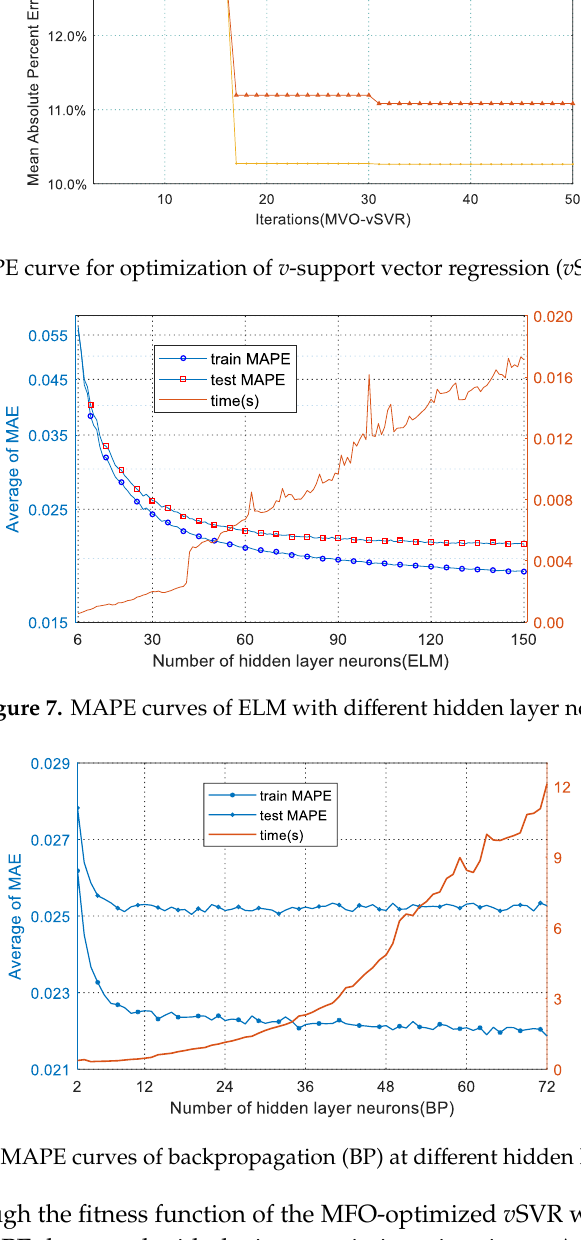
— In Table 6, the parameters of MFO-ELM (Gaussian) and MFO- v SVR are [C ag] and [c, g, v], while the parameters for ELM and BP are the number of hidden layer nodes. “ Time ” is the parameter optimization time. From Table 6, it can be seen that MFO- v SVR had the smallest MAPE in the test set at 11.082%, while the MFO-kELM had the smallest MAPE in the training set at 9.411%. However, kELM was more efficient, and its optimization time was 149.49 s, which was much less than the optimization time of 11,405.70 s for v SVR. The worst performance for cellular flow prediction was ELM, which had the largest MAPE in both the test and training sets. Differences between the results predicted by each regression algorithm and actual value of cellular traffic is shown in Figure 9. The standard deviation of kELM and vSVR was 0, while that of BP and ELM was not 0, i.e., the training results of kELM and v SVR were more stable. In addition, from Table 6, we can also see that the introduction of kernel functions in ELM to map features to high-dimensional space not only significantly improved the prediction accuracy of